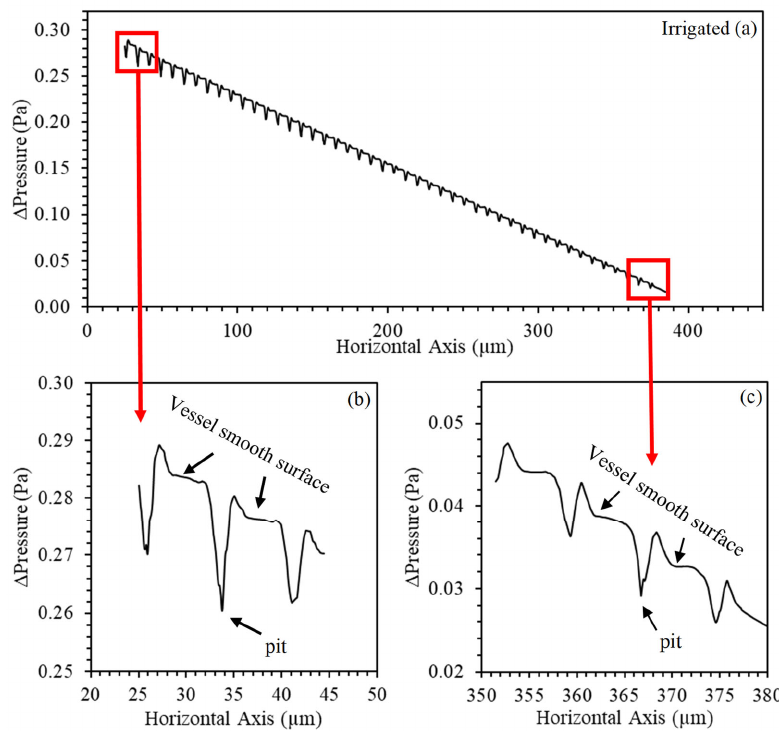
Figure 7. Numerical predictions of the pressure profile (Pa) generated along with the anatomical model in the longitudinal section of the irrigated Khaya grandifoliola xylem vessels. ( a ) The entire longitudinal axis; ( b ) input detail; and ( c ) output detail.